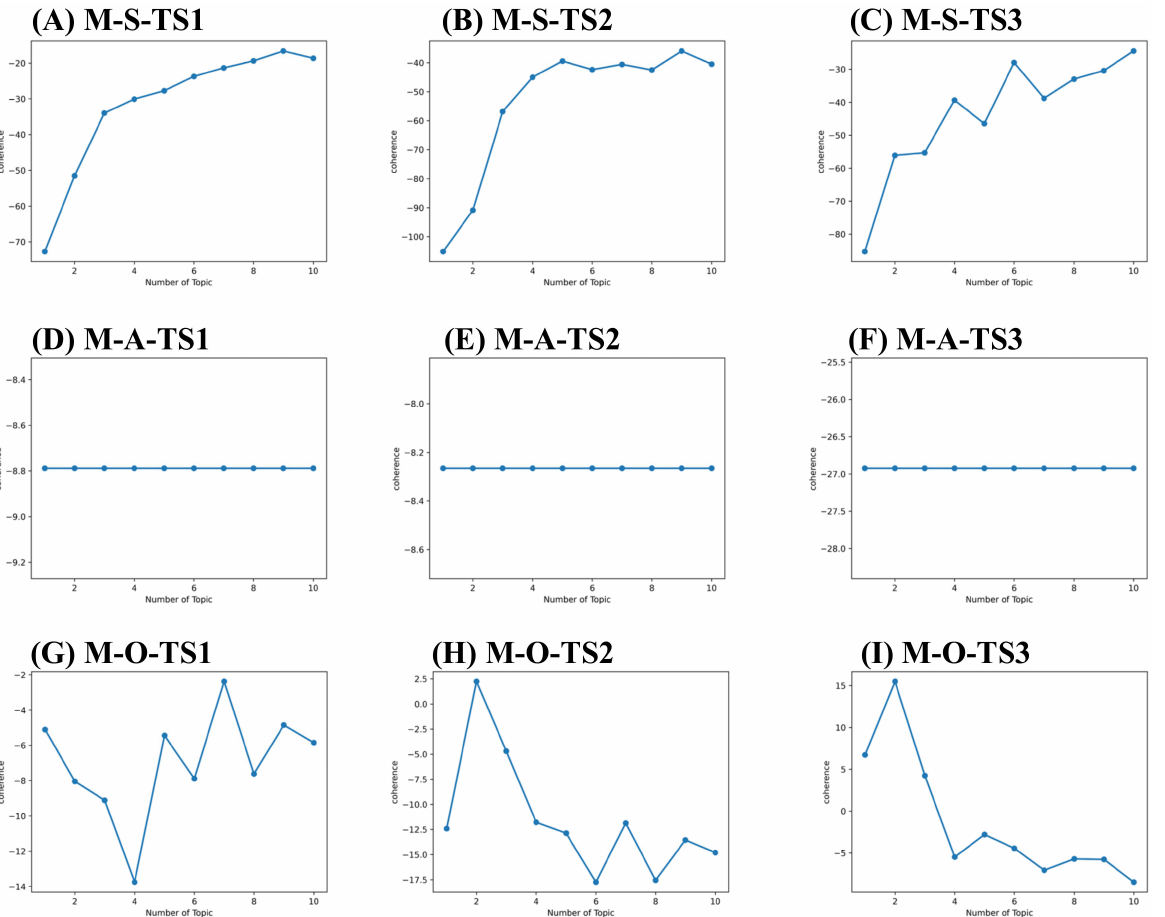
Figure 6. Topic coherence curve for market layer. ( A ) Topic coherence value of S components